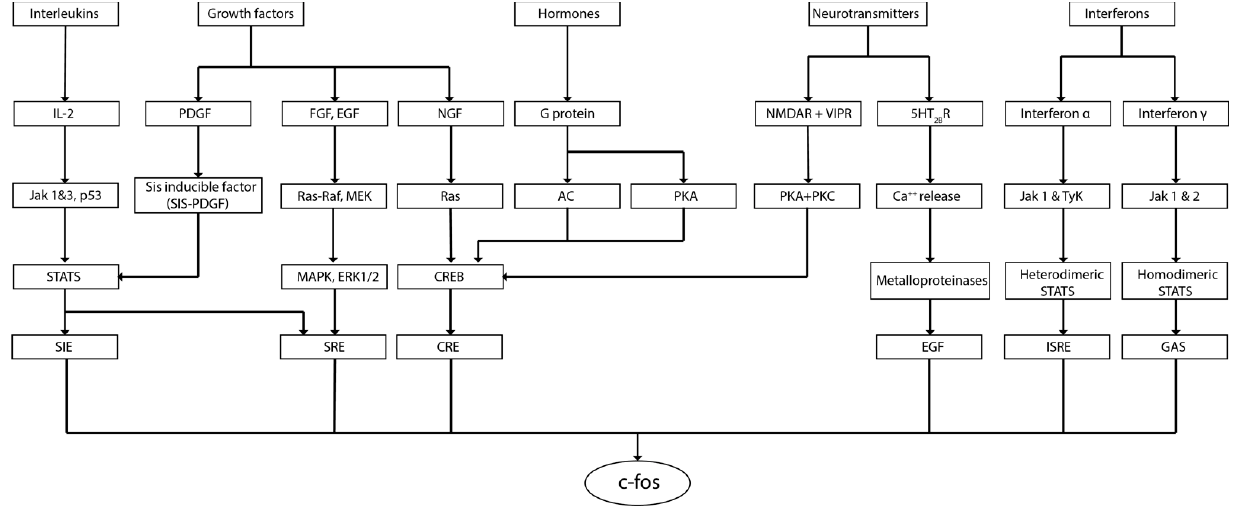
Figure 2. Cell signaling pathways that might induce c-fos expression.